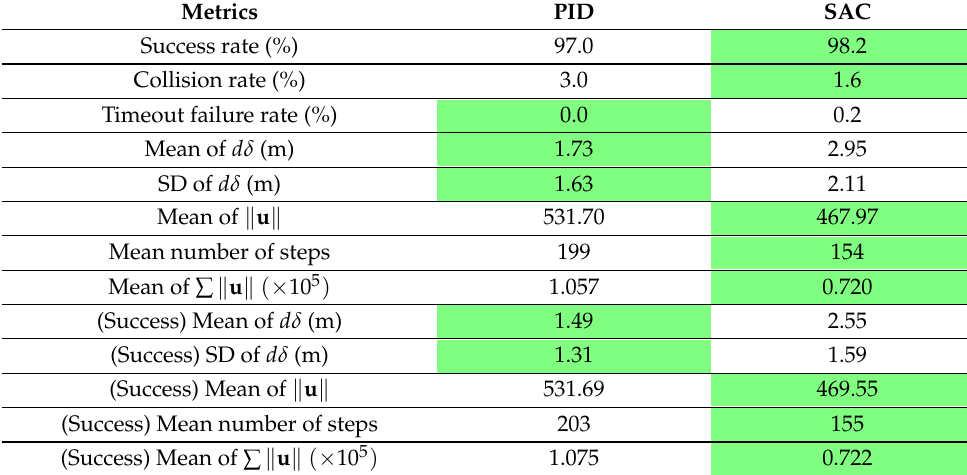
Table 3. Testing phase of a model based on the initial state vector, trained on 2500 episodes. For each metric, the controller with the best score is highlighted in